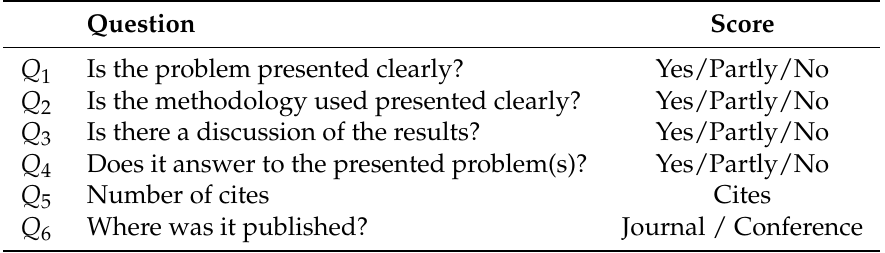
Table 10. Checklist for quality assessment